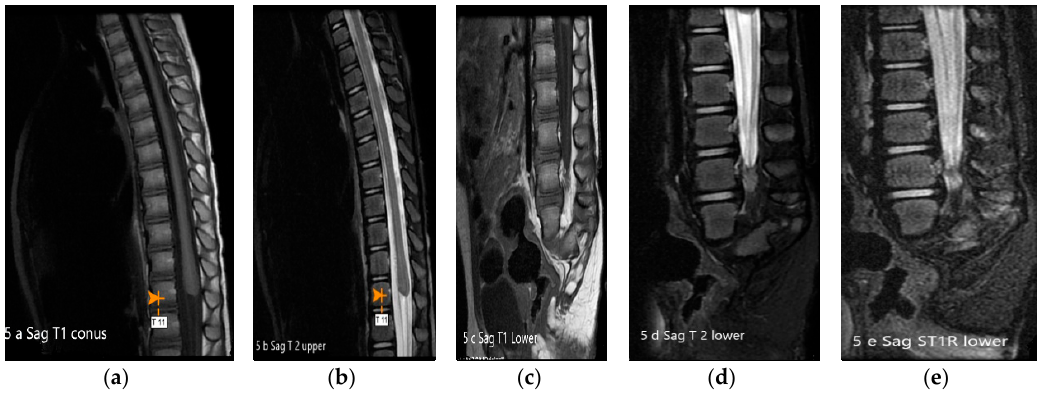
Figure 5. ( a – e ): MRI of spine T1, T2, T1 FS and T1 STIR images: The conus medullaris is truncated and nodular at the level of intrapedicular T11 with rudimentary dysgenetic sacrum and sagittal cleft in the median sacrum with rudimentary apophysis. Thickened cauda equine is seen. FS—fat suppression. STIR—short T 1 inversion recovery.